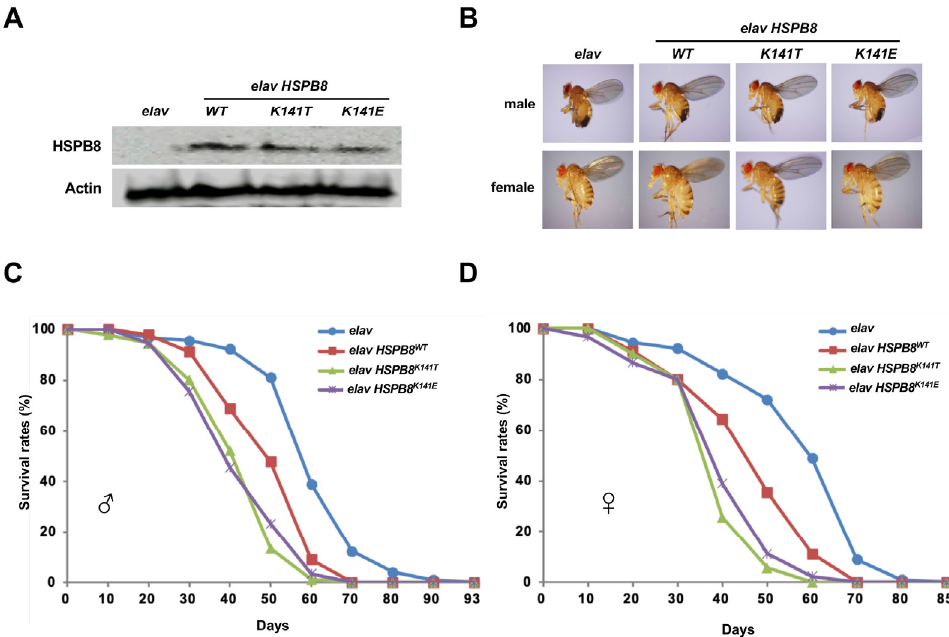
Figure 1. Characterization of HSPB8 transgenic flies. ( A ) Western blot analysis of HSPB8 proteins in elav ‐ GAL4 ( elav ), HSPB8 WT ( elav HSPB8 WT ), HSPB8 K141T ( elav HSPB8 K141T ) and HSPB8 K141E ( elav HSPB8 K141E ) expressing flies. Actin was used as a loading control. ( B ) Photographs of 5 ‐ day ‐ old male and female flies. ( C ) Lifespan assays of male flies (log ‐ rank test: elav vs. elav HSPB8 WT : p < 0.001, elav HSPB8 WT vs. elav HSPB8 K141T , elav HSPB8 WT vs. elav HSPB8 K141E : p < 0.01, n = 90 per group). ( D ) Lifespan assays of female flies (log ‐ rank test: elav vs. elav HSPB8 WT : p < 0.001, elav HSPB8 WT vs. elav HSPB8 K141T , elav HSPB8 WT vs. elav HSPB K141E : p < 0.01, n = 90 per group). All lifespan assays were conducted at 25 °C and were repeated at least twice.